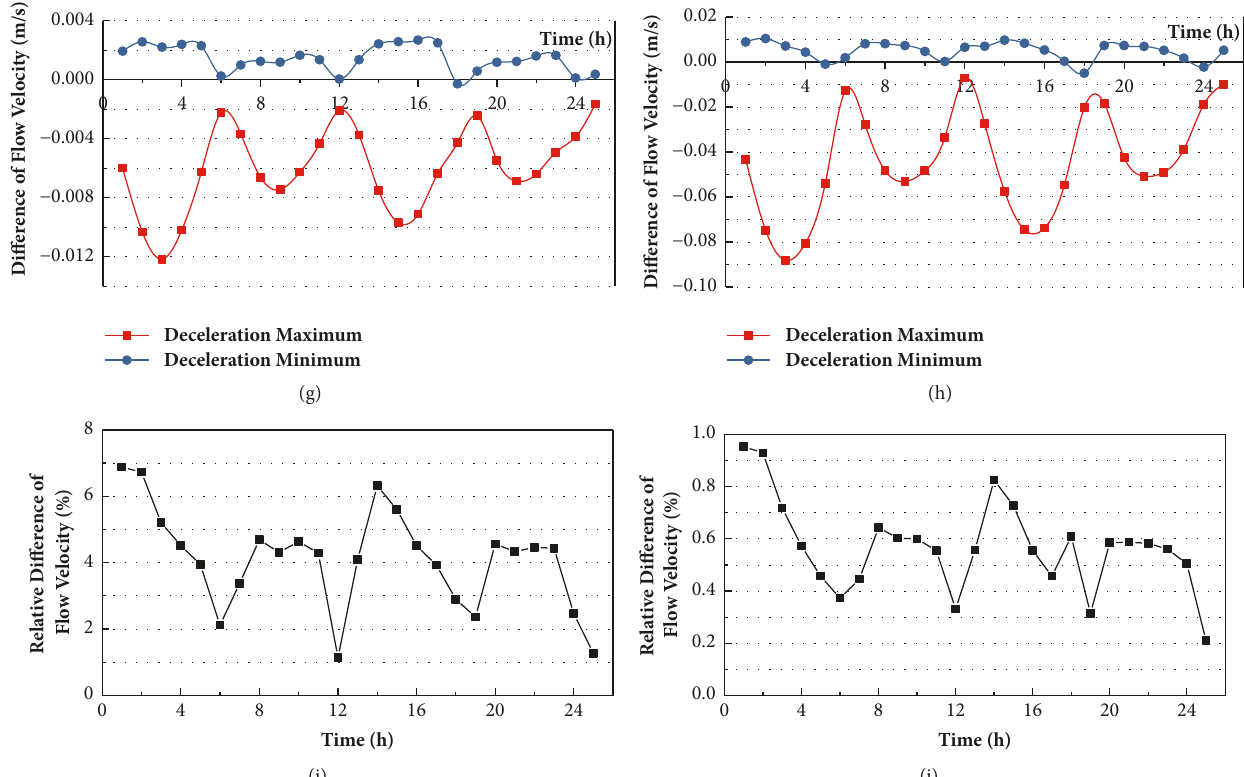
Figure 15: Variations in flow velocity of circumference with radius of 200 m: (a) and (b) represent B1 location; (c) and (d) represent B2 location; (e) and (f) represent B3 location; (g) and (h) represent B4 location; and (i) and (j) represent B5 location.